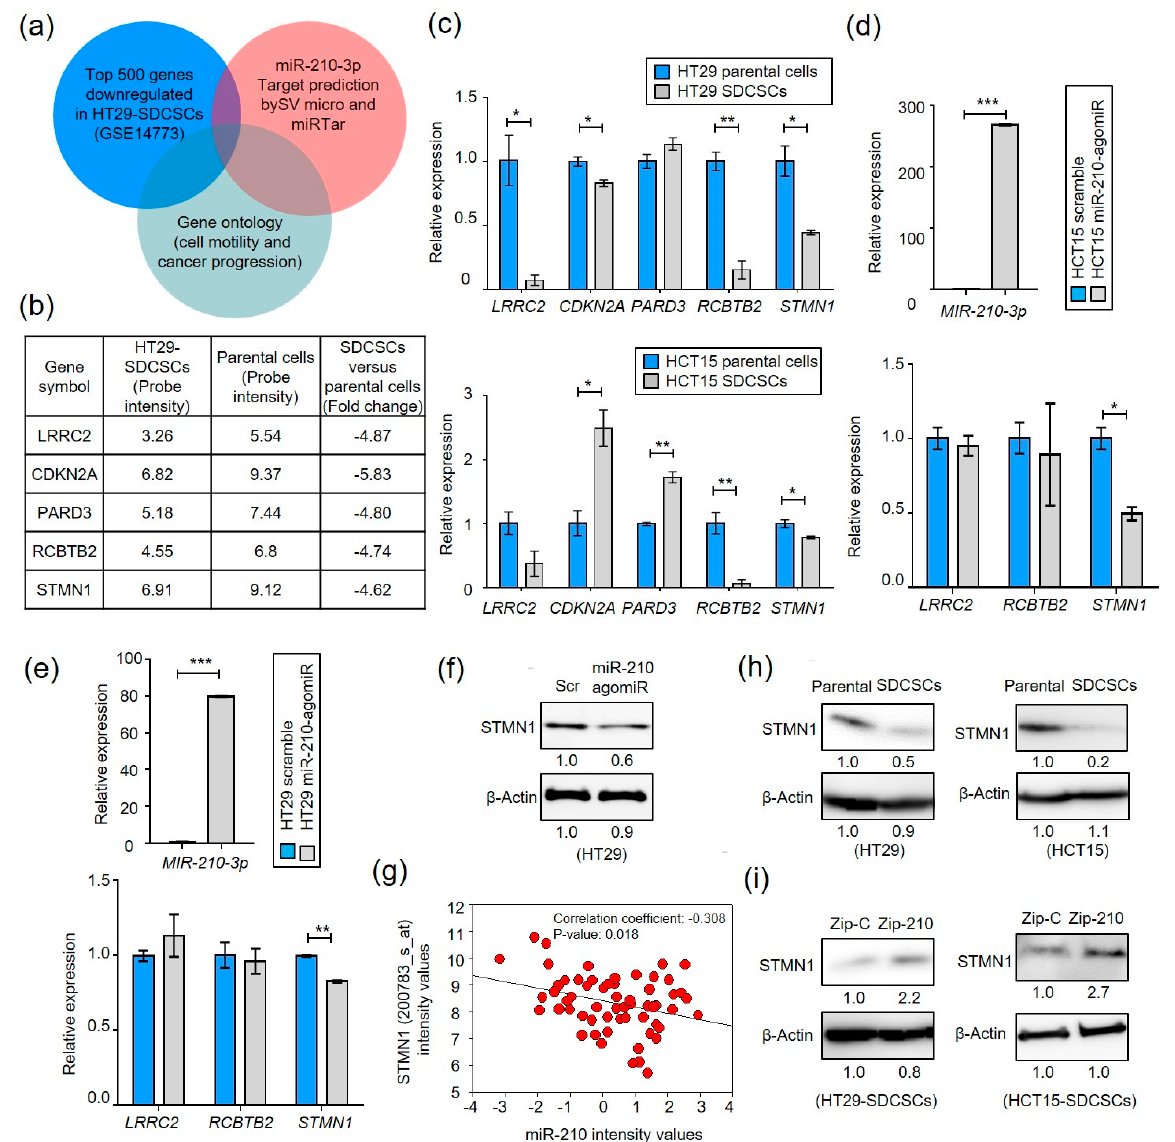
Figure 3. Identification of the miR-210-3p-STMN1 axis in SDCSCs. ( a ) Strategy for identifying miR-210 targets. The putative targets were obtained from the set of differentially expressed genes in SDCSCs versus parental HT29 cells (GSE14773) and subjected to target prediction with SVmicro. Migration-, tumor suppressor- and stemness-related genes were selected. ( b ) A table illustrating the expression levels of five candidate targets of miR-210-3p from microarray analysis. ( c ) RT-qPCR examining the expression of five candidate targets of miR-210-3p in SDCSCs and their parental cells. ( d , e ) RT-qPCR examining the expression of miR-210-3p or LRRC2, RCBTB2 and STMN1 in HCT15 cells ( d ) and HT29 cells transfected with control agomiR (Scramble, 100 nM) or miR-210-3p agomiR (miR-210-AgomiR, 100 nM). ( f ) Western blot showing the expression of STMN1 in HT29 cells transfected with control agomiR (Scramble, Scr, 100 nM) or miR-210-3p agomiR (miR-210-AgomiR, 100nM). ( g ) Analysis of the NCI-60 panel revealed an inverse correlation between STMN1 (200783_s_at) and miR-210-3p expression. The pvalue of the Pearson correlation was assessed, and the correlation coefficient is reported. ( h ) Immunoblots showing STMN1 expression. ( i ) Western blots showing the expression of STMN1 in control SDCSCs (Zip-C) and miR-210-3p-silenced SDCSCs (Zip-210). Data in bar charts are expressed as the mean ± SD values. * p < 0.05; ** p < 0.01; *** p < 0.001 (Student’s t